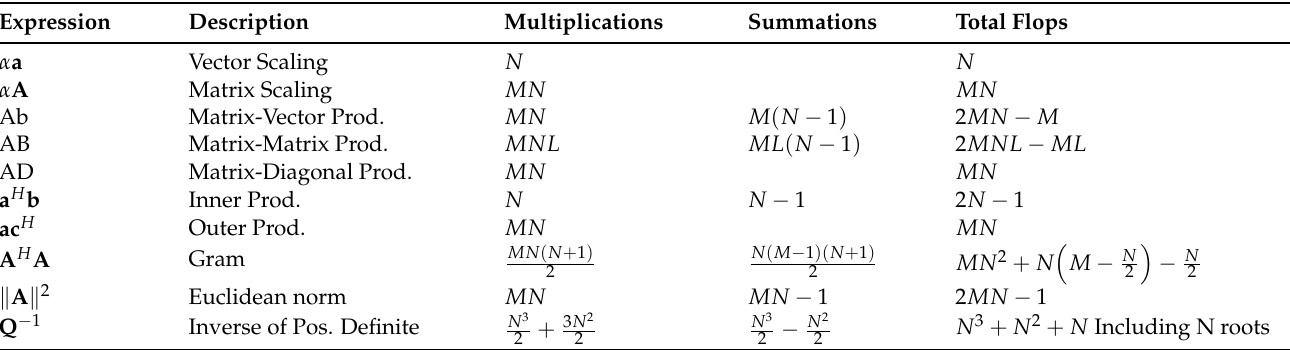
Table 1. Complexity cost of matrix-vector operations